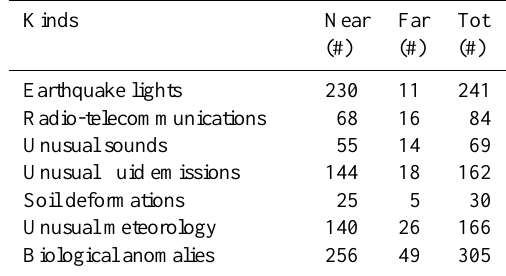
Table 2. The different kinds of phenomena collected after 6 April 2009, near and far from the city of Aquila. Near means < 20km from the epicenter, far means > 20km from the